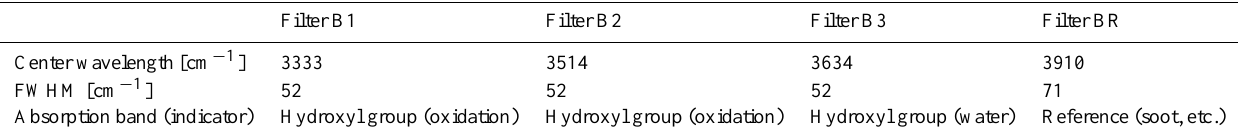
Table 2. Filter parameters of the band-pass filters for analysis of ester-based hydraulic fluids (filter combination B, ester